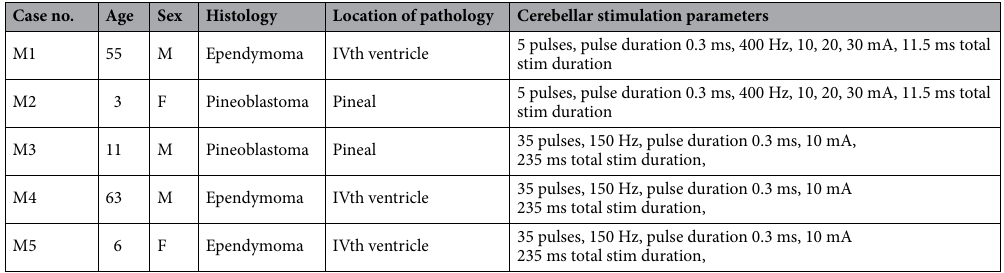
Table 2. The summary of recruited patient demographic, stimulation parameters for motor mapping.